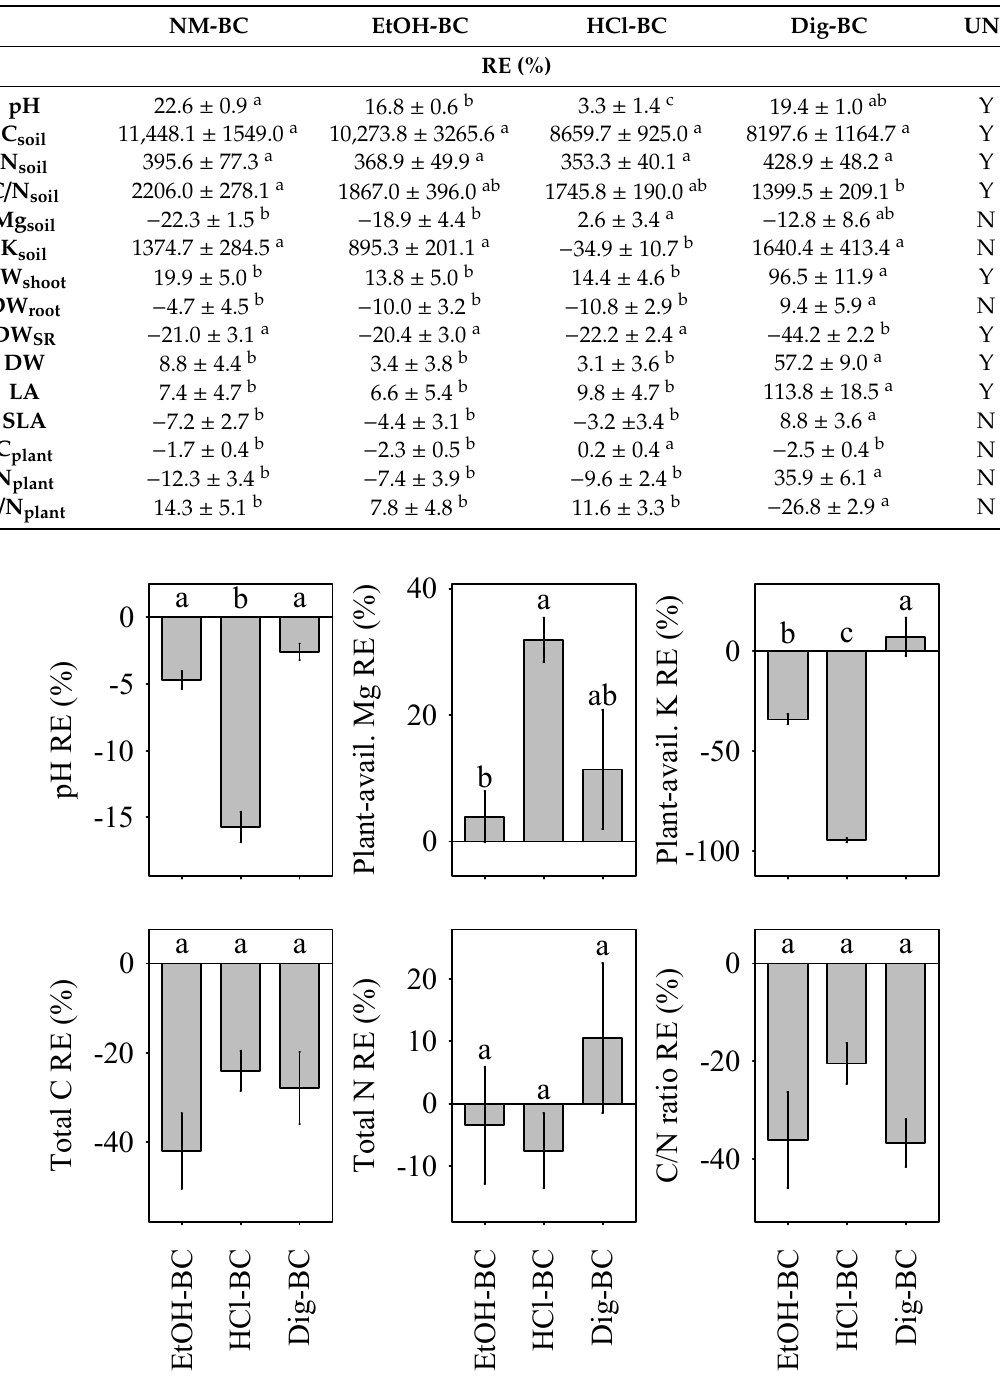
Table 1. Relative e ff ects (RE, %) of biochar amendment via NM-BC, EtOH-BC, HCl-BC, and Dig-BC on all examined soil and plant parameters in contrast to the negative control (unamended sand). Uniformity of response (UNI) indicates whether all four treatments exhibit the same e ff ect directionality. Y: Yes, N: No. DW: dry weight, SR: shoot to root ratio, LA: leaf area, SLA: specific leaf area. Superscript letters indicate the results of the Tukey test ( α = 0.05).